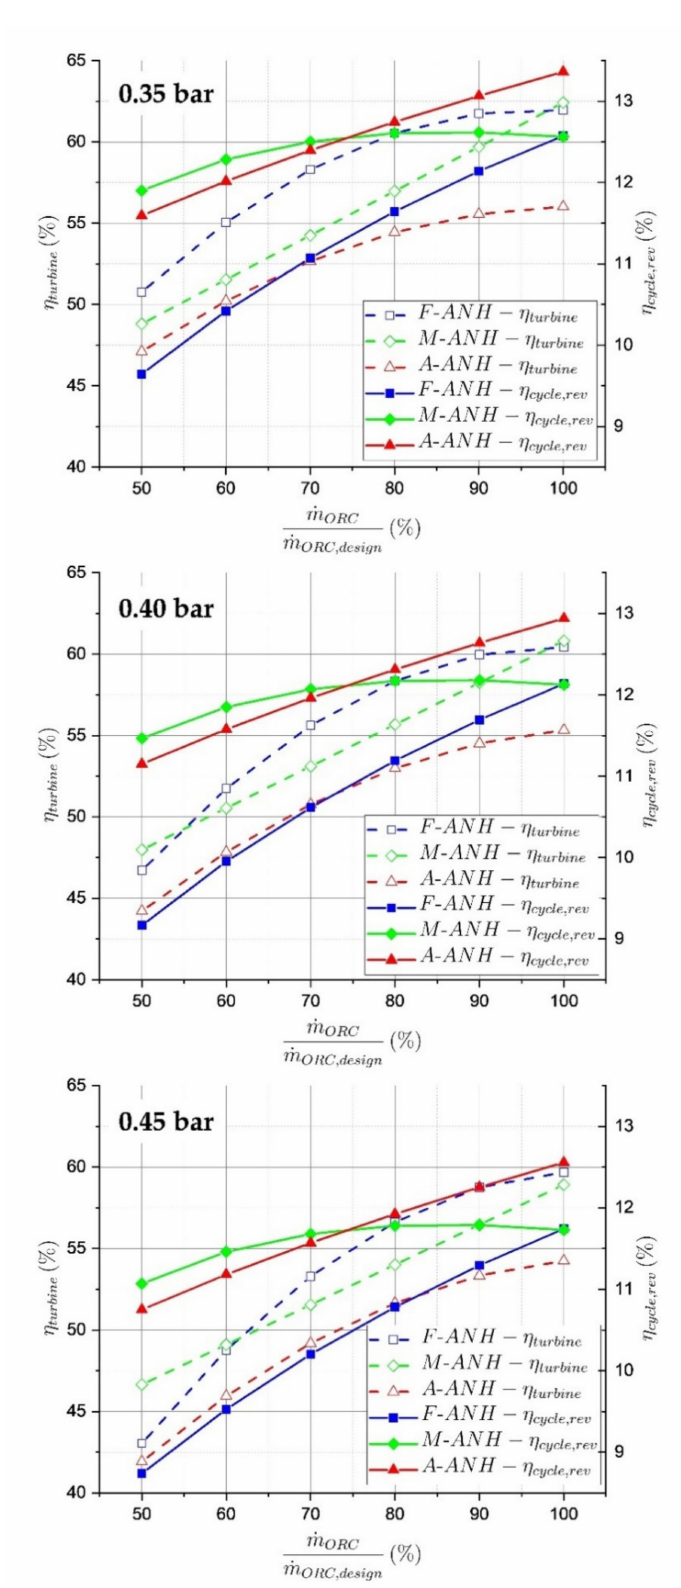
Figure 10. Total-to-static isentropic turbine efficiency and reversible cycle efficiency in dependency on the working fluid mass flow rate, calculated by the digital twin for 0.35, 0.40 and 0.45 bar turbine outlet